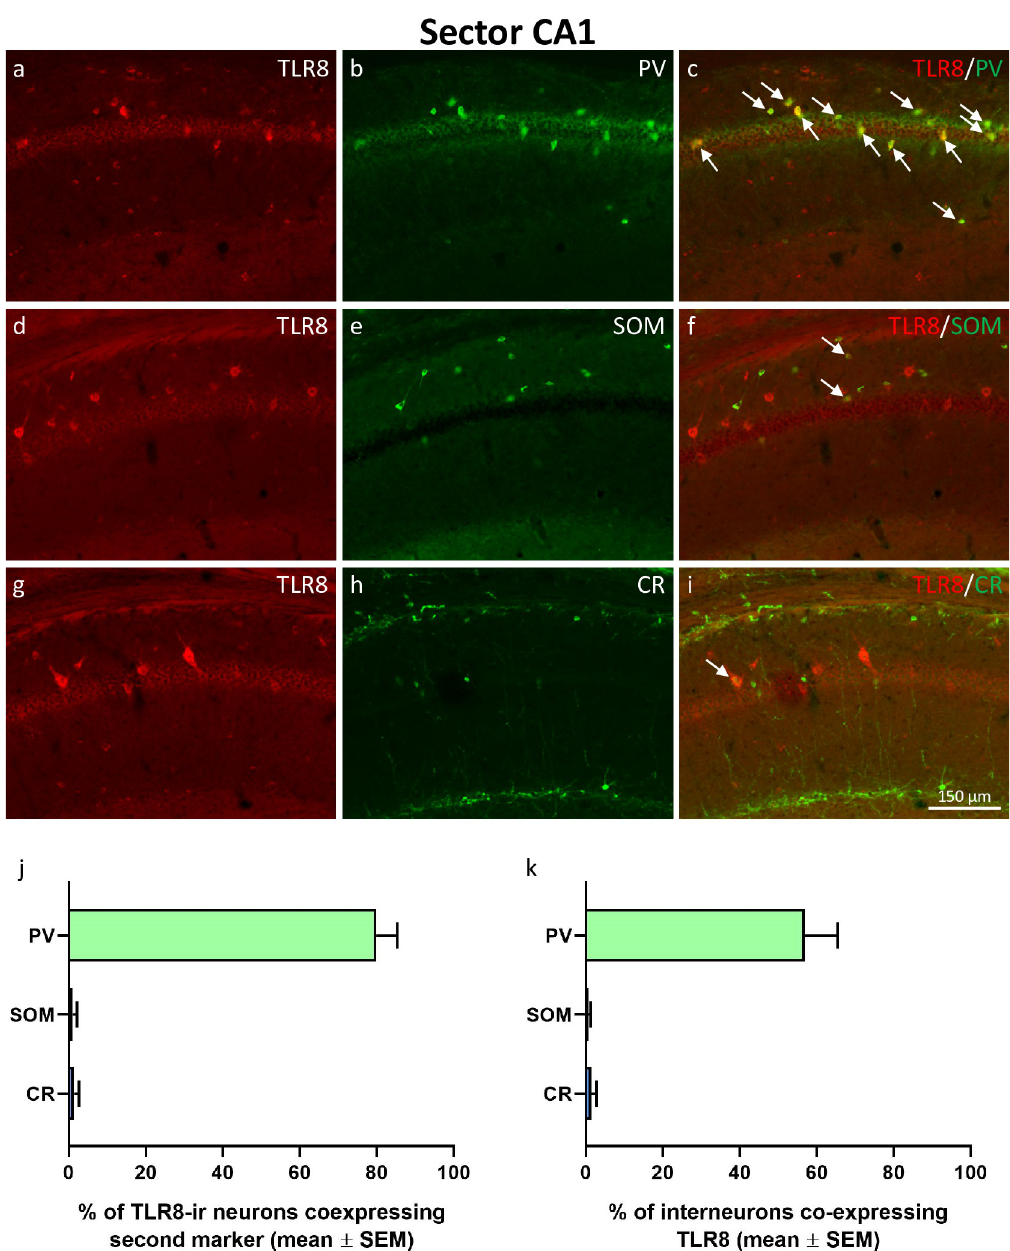
Fig 6. Expression of TLR8 in GABAergic interneurons of hippocampal sector CA1. Double-immunofluorescence of TLR8 together with parvalbumin (PV, a-c), somatostatin (SOM, d-f), and calretinin (CR, g-i). TLR8 was co-expressed in PV-ir interneurons in stratum oriens, stratum pyramidale, and at the border between stratum radiatum and stratum lacunosum- moleculare (c). Co-expression of TLR8 together with SOM was mainly present in a low number of SOM-interneurons in stratum oriens (see arrows in f). Co-labeling of TLR8 together with CR was rarely observed in sector CA1 (g-i; see arrow in i). Quantification of co-labeling revealed that 79.9 ± 5.47% of TLR8-interneurons also expressed PV, but only 1.1 ± 1.11% co- expressed SOM, and only 1.3 ± 1.32% co-expressed CR (see panel j). Vice versa, quantification of co-labeling showed that 56.8 ± 8.67% of PV-interneurons, 0.6 ± 0.61% of SOM-interneurons, and only 1.4 ± 1.39% of CR-interneurons co-expressed TLR8 (see panel